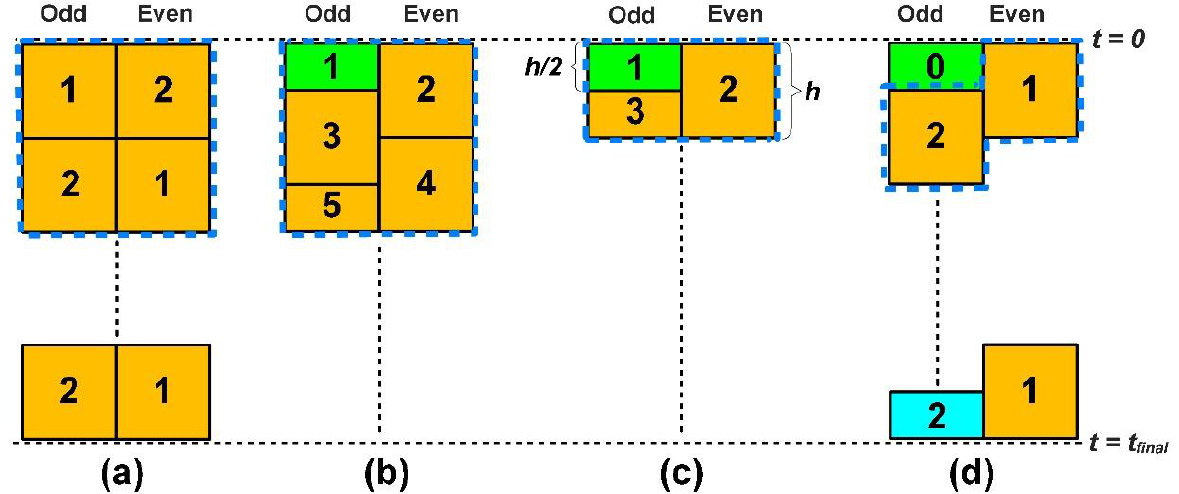
Figure 1. Space-time structure of the hopscotch-type algorithms. ( a ) Original odd – even hopscotch (OOEH), ( b ) shifted-hopscotch (SH), ( c ) asymmetric hopscotch (ASH), ( d ) leapfrog-hopscotch (LH).